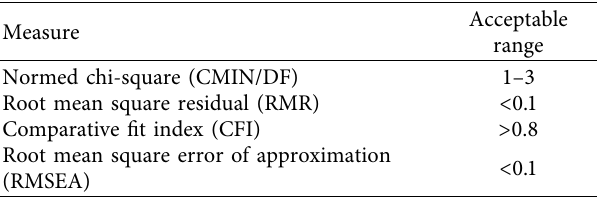
Acceptable range